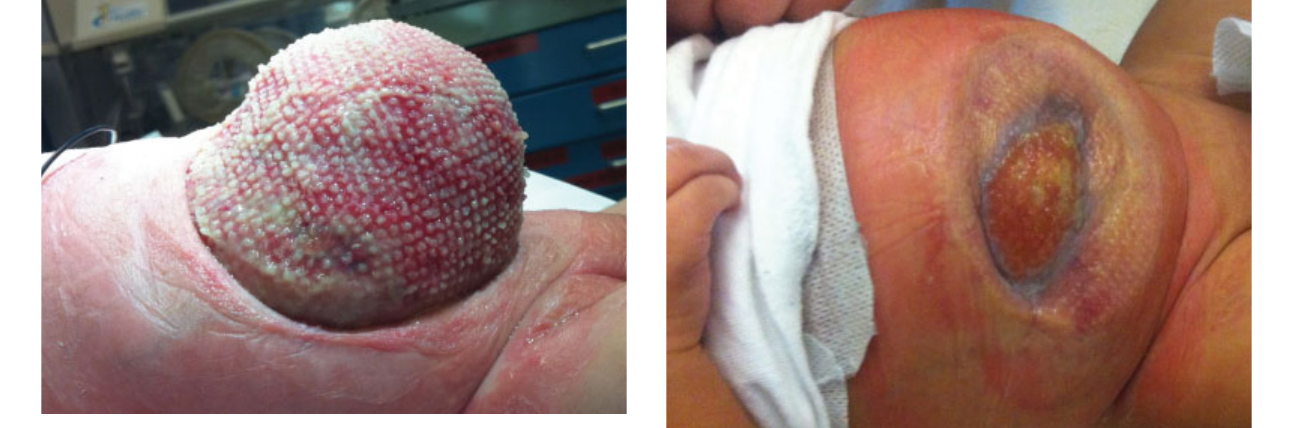
Fig. 2 Gastroschisis on day of life 29, 7 days after vacuum-assisted closure dressing was placed, showing consolidation of herniated abdominal contents.